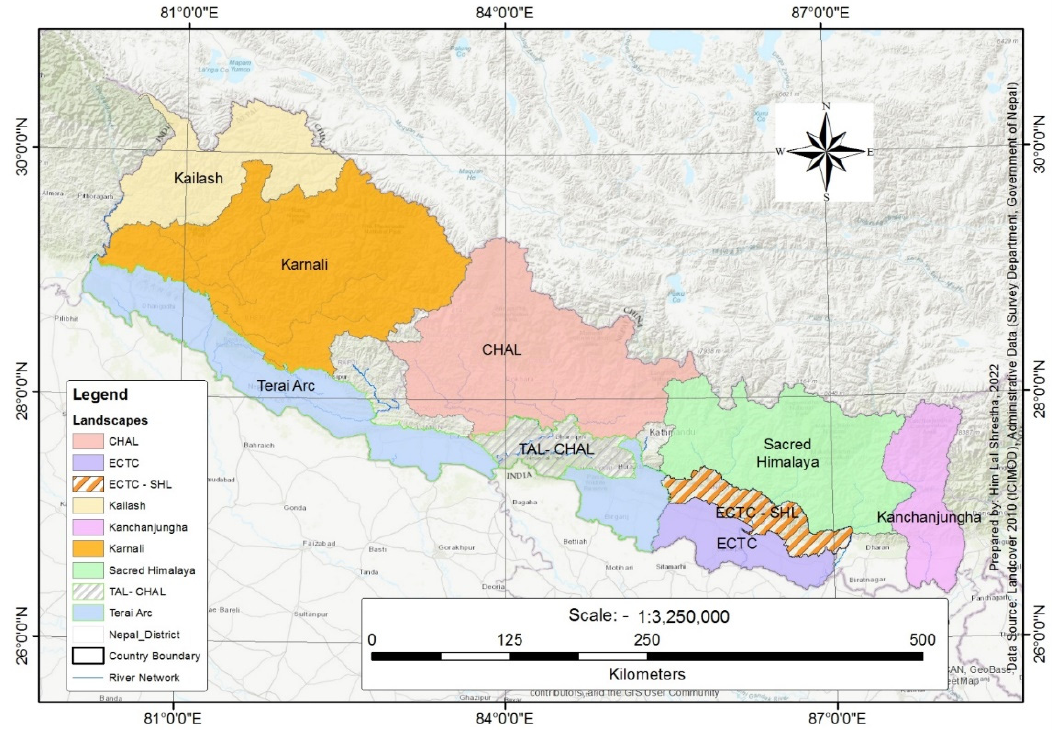
Figure 3. Landscapes scaled decarbonization and wildlife conservation plan in Nepal [Source: [76]].